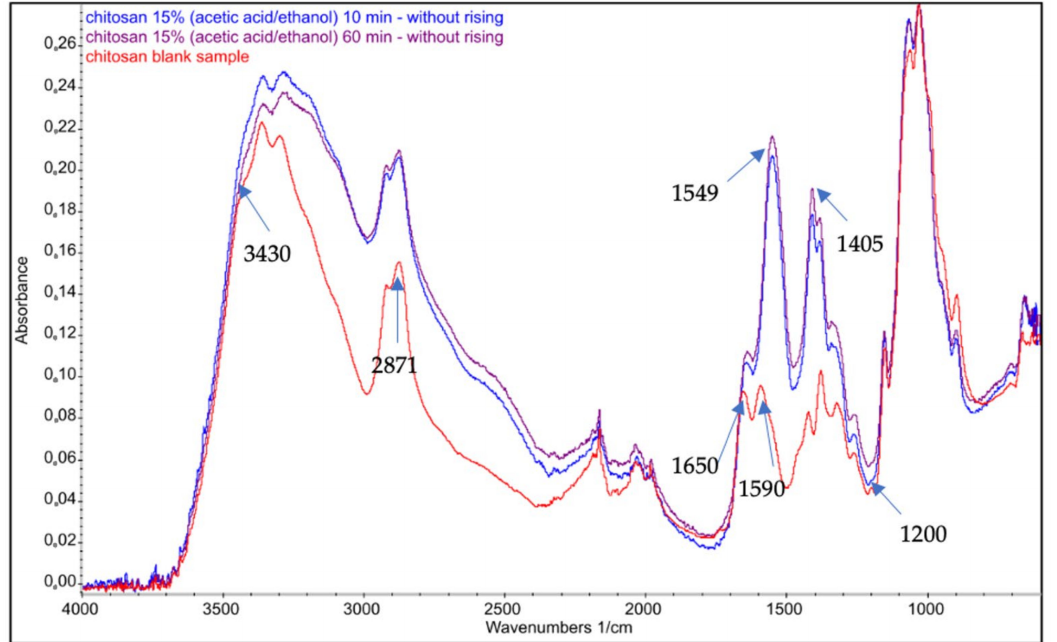
Figure 4. Example FTIR–ATR spectra for a nonwoven treated with acetic acid vapor without